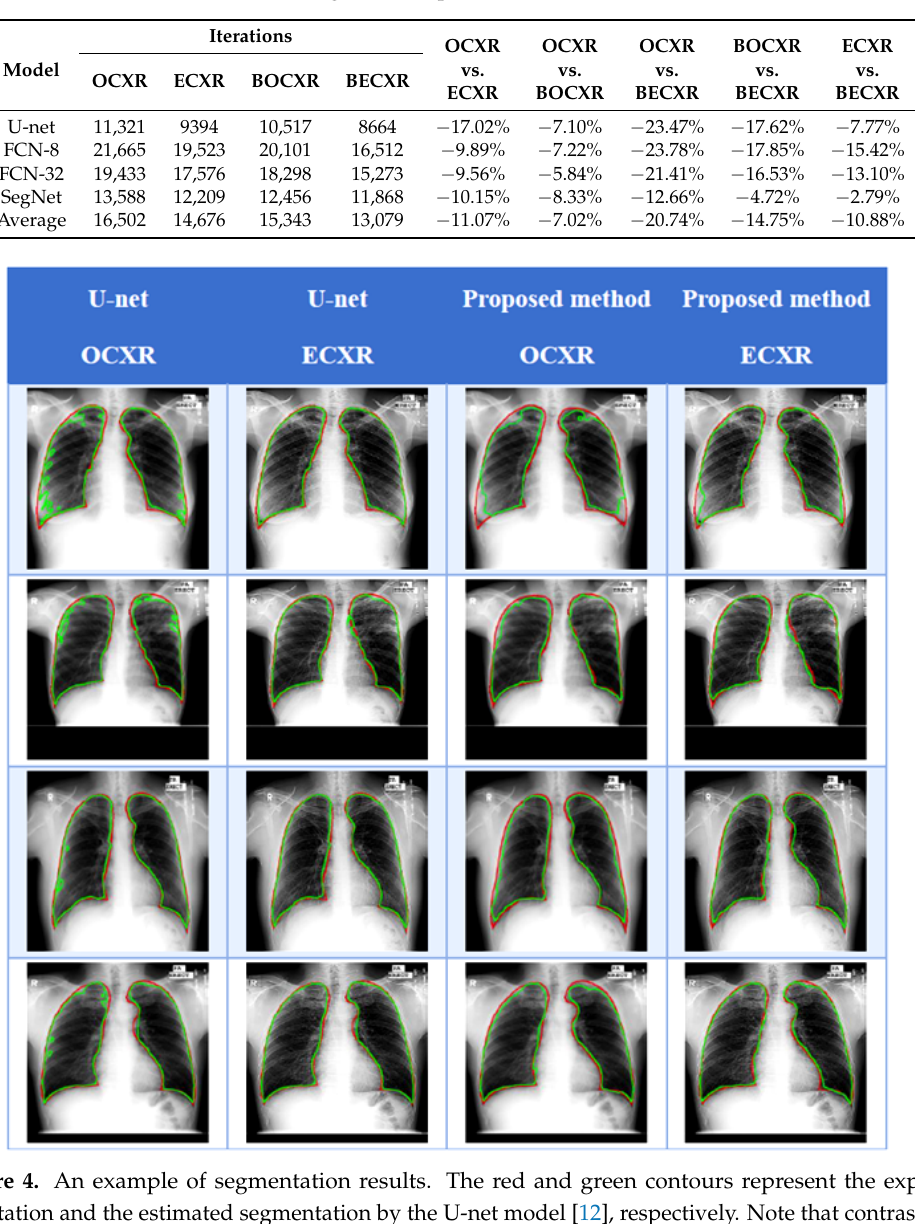
Table 2. The comparisons of the convergence rates (measured using numbers of iterations needed for the training of the models to converge) using different pre-processing approaches. The second to fifth columns list the total iterations for convergence. The sixth to tenth columns list the iteration reduction percentages “A” versus “B” (e.g., original chest X-ray (OCXR) vs enhanced chest X-ray (ECXR)). The last row shows the average with respect to each column.